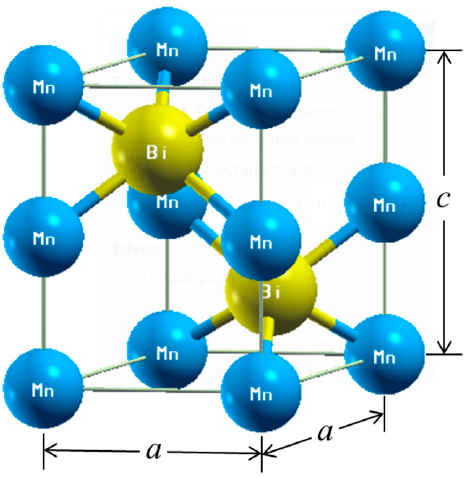
Figure 1. Hexagonal low-temperature phase (LTP) MnBi. The Mn and Bi atoms are blue and yellow, respectively.